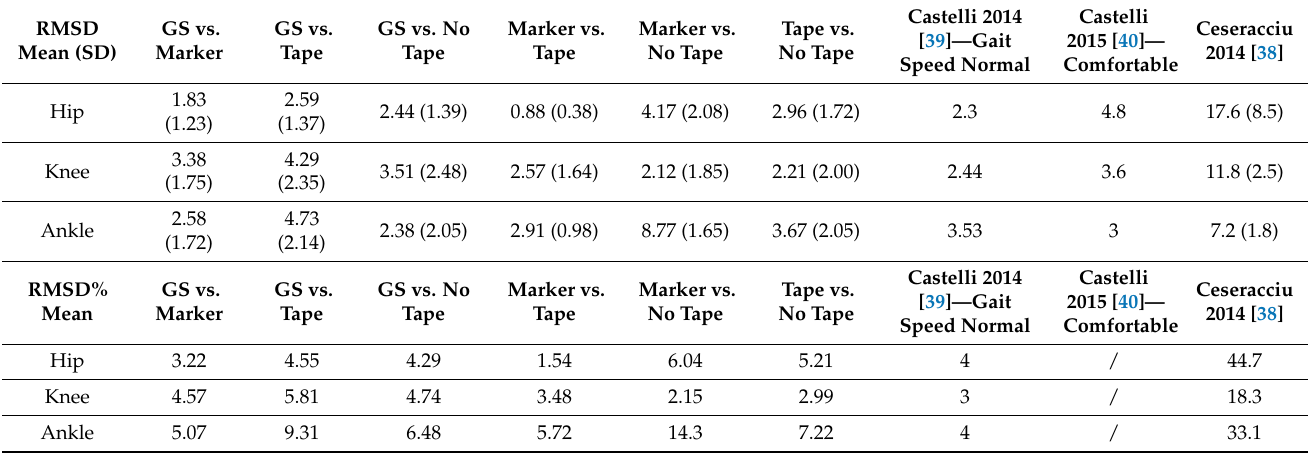
Table 2. Comparison of RMSD and RMSD in % of the Gold Standard, in terms of mean and standard deviation (SD), for each set up and for each joint angle, with those assessed by [38–40]. RMSD GS vs. Mean (SD)